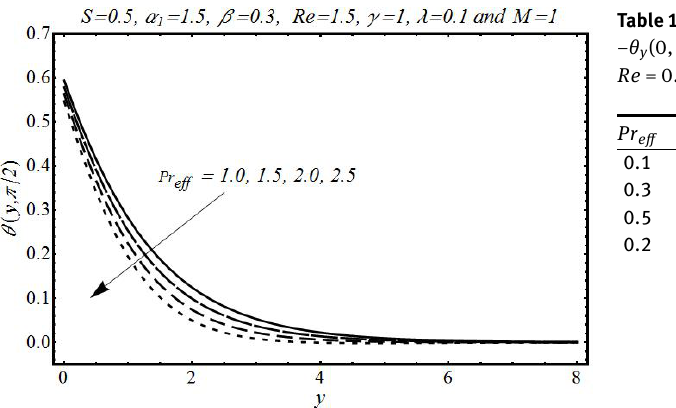
Figure 9: Effects of Pr eff on temperature